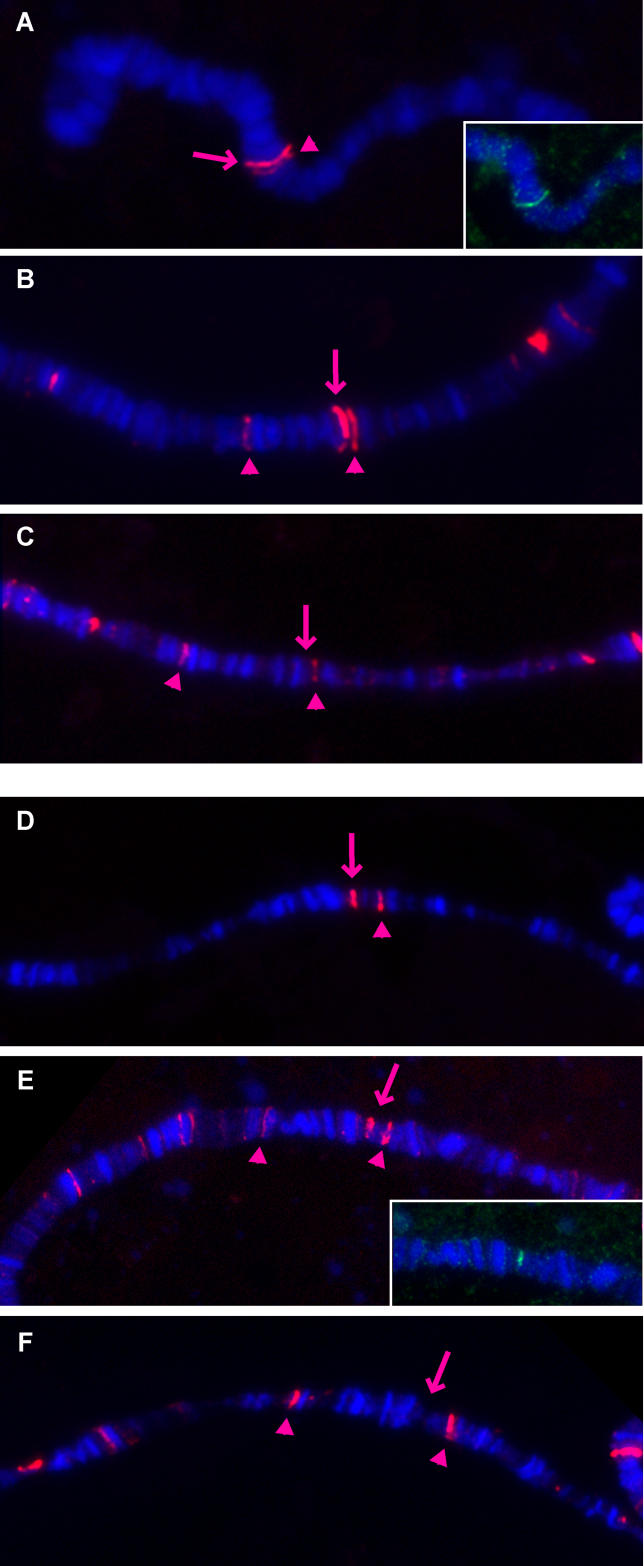
Minimal Spreading from High-Affinity Sites to Low-Affinity Autosomal SitesExamples of two inserts, DBF9-96C (A–C) and DBF5-91F (D–F), that cause occasional spreading of the DCC to one additional band next to the insertion site in wild-type males (A and D). When complex levels are increased by over-expression of MSL1 and MSL2, the secondary DCC binding sites appear as part of the set of autosomal binding sites for the complex (B and E) and are present even in the absence of the DBF insert (C and F). Anti-MSL1 staining is shown in red and DNA staining in blue. Small inserts in (A) and (E) show the FISH signals (green) corresponding to the P element insertion. Arrows indicate the position of the inserts and arrowheads indicate autosomal sites of DCC binding.